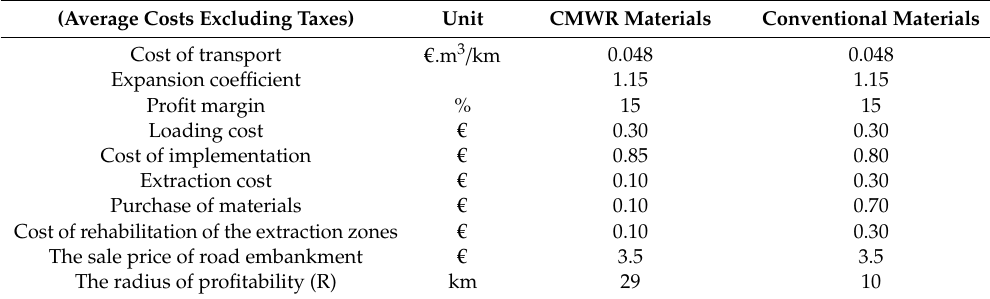
Table 10. Calculation of the radius of